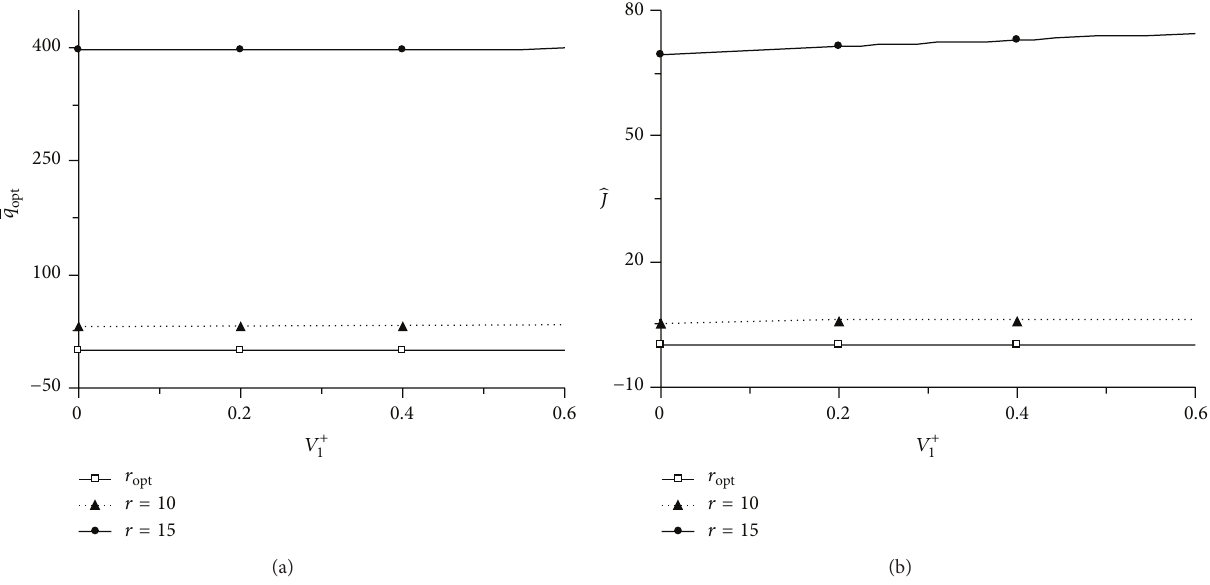
Figure 5: Effect of the thickness ratio 𝑟 and volume fraction 𝑉 + 1 on curves of the control force 𝑞 and 𝑎/𝑏 = 1